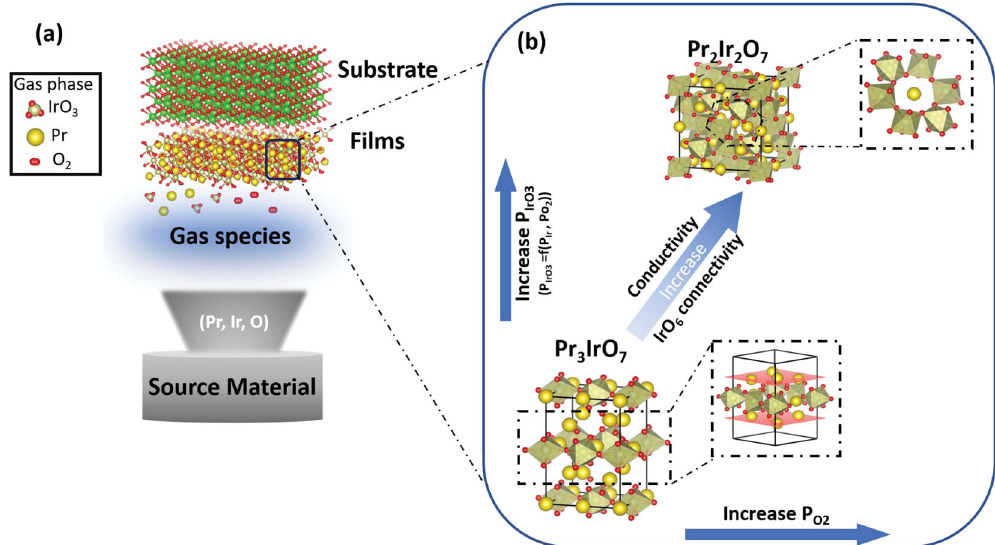
Fig. 1 Schematic in situ co-sputtering thin- fi lm deposition. In the actual experiment, Pr 2 Ir 2 O 7 and IrO 2 targets are simultaneously sputtered, ( a ). The details are included in Supplementary Fig. 2. The condensation of the vapor species is key to the thin- fi lm synthesis, ( b ). By synthesizing epitaxial Pr 2 Ir 2 O 7 thin fi lms, we can tailor the properties based on breaking the cubic symmetry. The strong spin – orbital coupling, originating from the Ir, opens paths toward a new generation of spintronics based on frustrated antiferromagnetic (AFM) conductors.